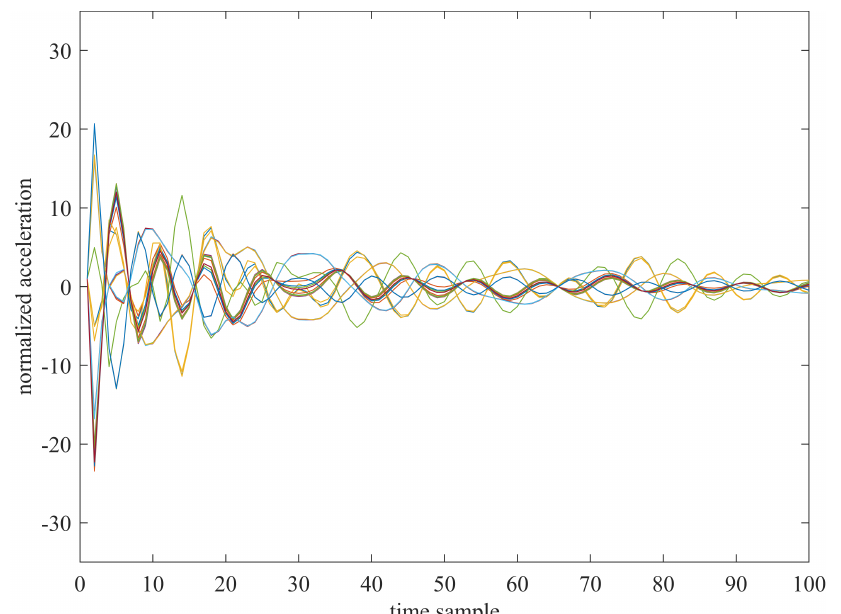
Figure 6. Time − series behaviour (first 100 time samples) of the 36-sensor data relevant to one of the 231 observations of the dataset with the undamaged system (class label “0”).